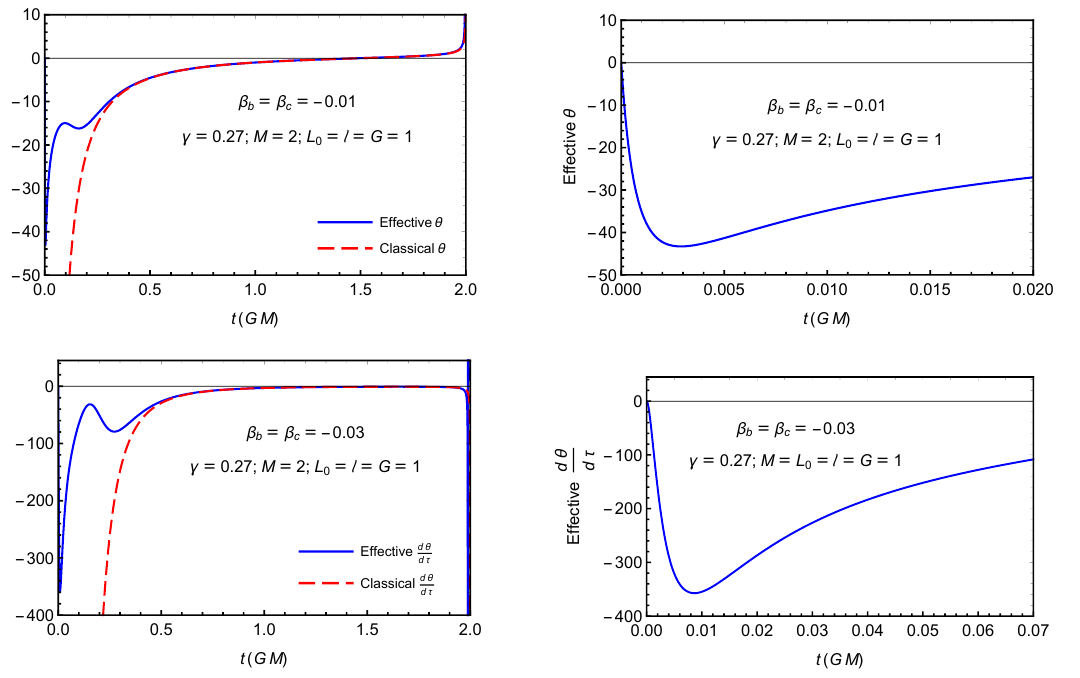
Figure 4 . Plots of expansion and its rate of change for model 1. Top left: classical vs effective θ as a function of the Schwarzschild time t . Top right: closeup of the effective θ as a function of t . Bottom left: classical vs effective dθ as a function of t . Top right: closeup of the effective dθ dτ function of t